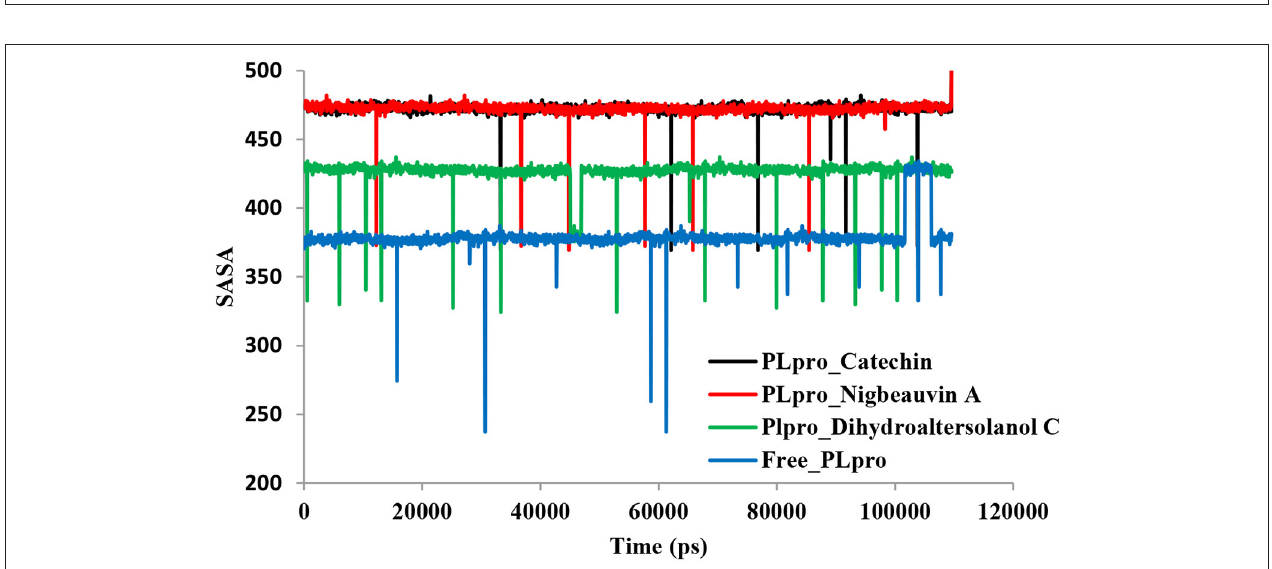
FIGURE 4 | Time series for the protein volume with expansion analyses for the PLpro-ligand complex and Free-PLpro alpha carbon atoms simulated systems. PLpro-Catechin code: black, PLpro-Nigbeauvin A code: red, PLpro-Dihydroaltersolanol C code: green, and Free-PLpro code: blue.